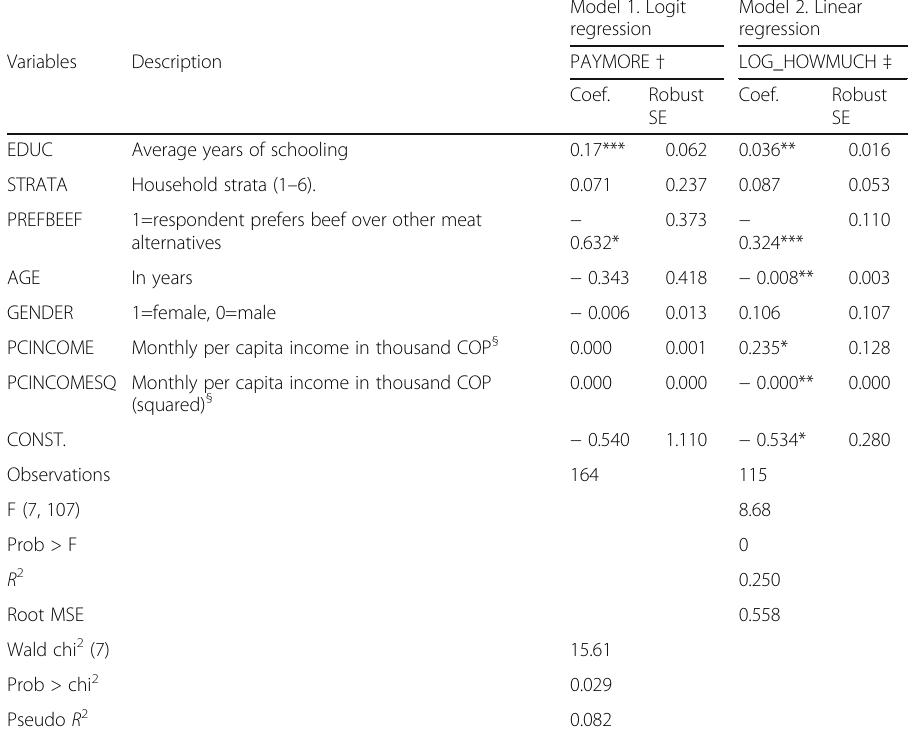
Model 1. Logit regression